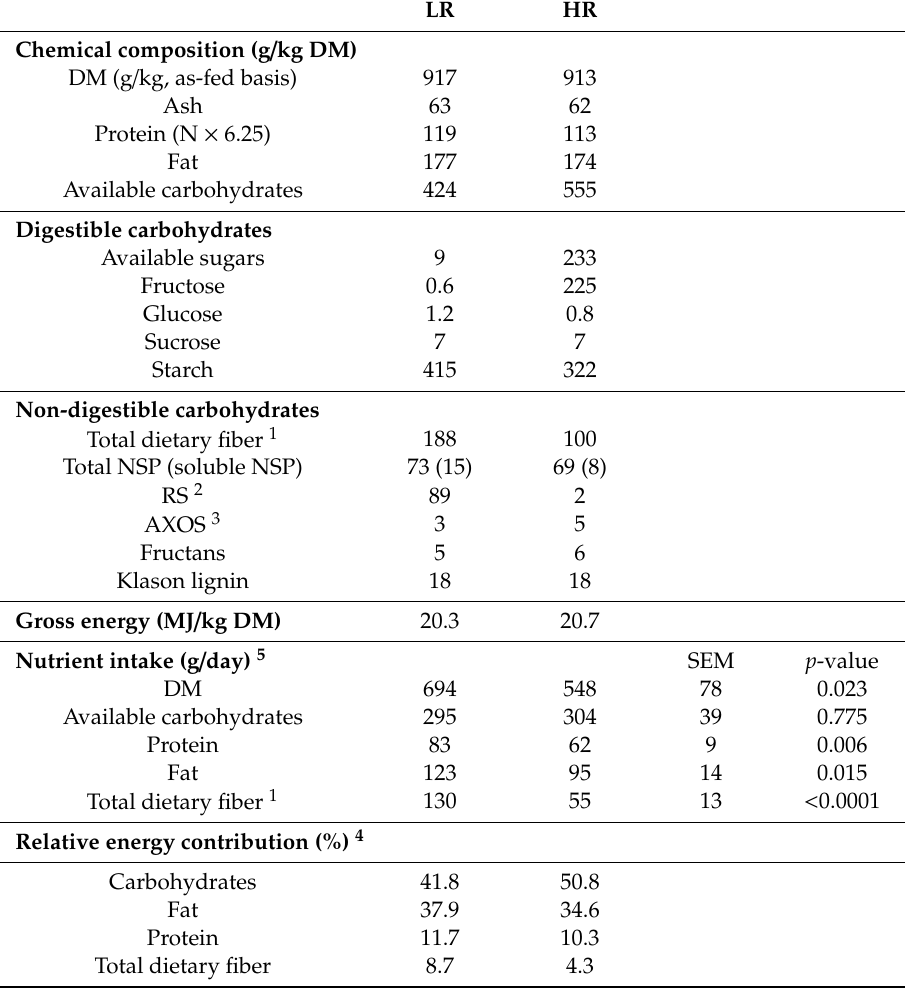
Table 1. Chemical composition, nutrient intake, and relative energy contribution of the lower-risk (LR) and the high-risk (HR) experimental